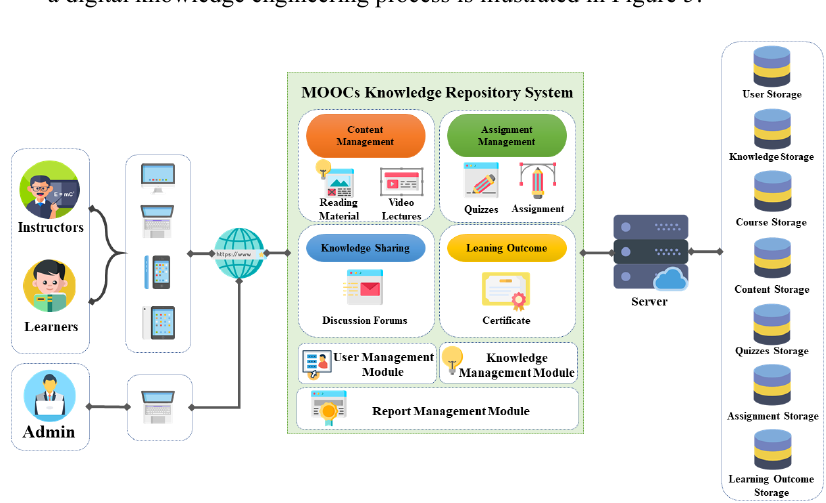
Fig. 5. The system design architecture of a MOOCs knowledge repository system using a digital knowledge engineering